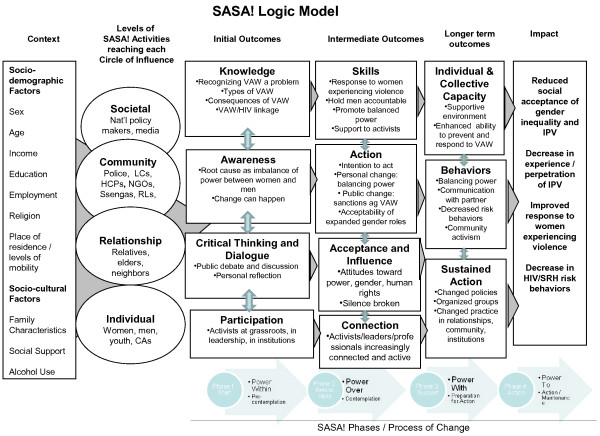
SASA! Logic model.